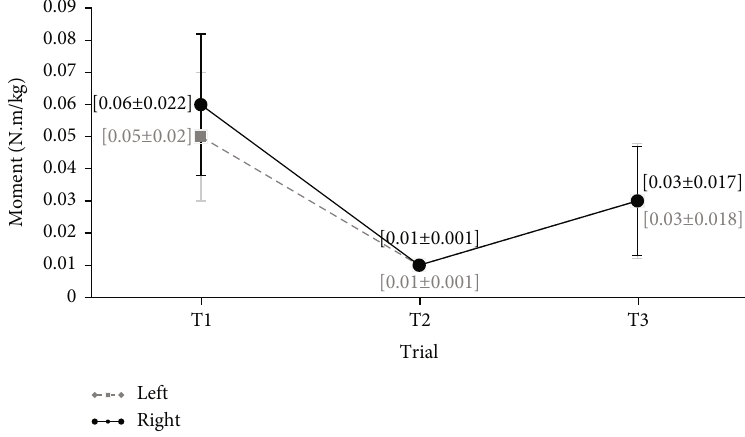
Figure 6: Mean values of ulnar-radial deviation of the wrists moments in three distances of the keyboard